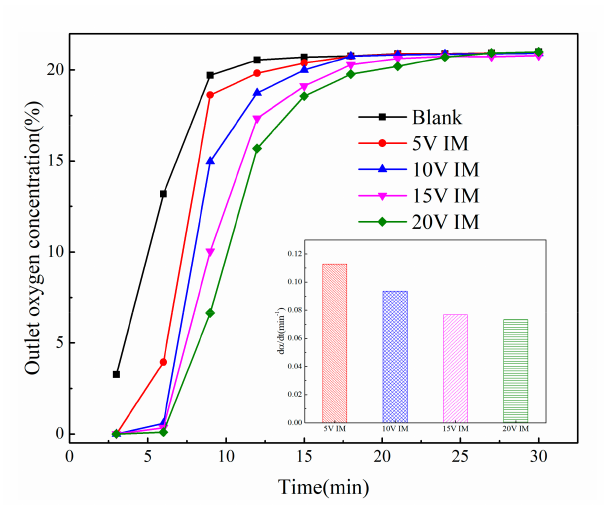
Figure 6. The re-oxidation performance of V-based oxygen carriers with different V loadings prepared by the impregnation method at 435 ◦